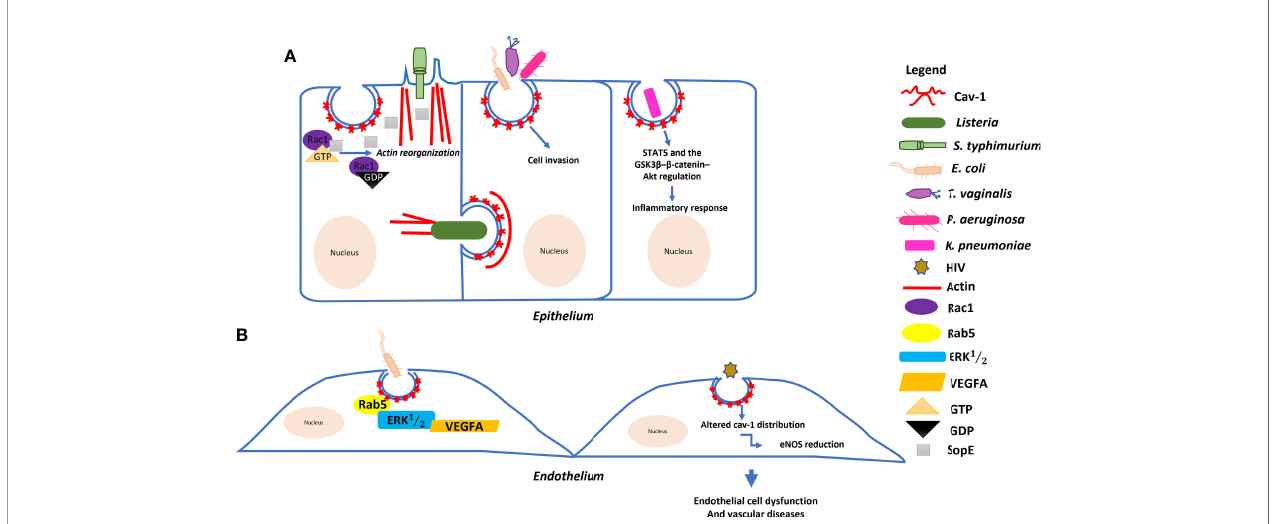
FIGURE 2 | Model of the molecular mechanism underlying the role of Cav – 1 in bacterial and HIV invasion: (A) Salmonella typhimurium delivers SopE effector proteins into the host cell through a type III secretion system. SopE activates Rac1 leading to the activation of actin reorganization. Cav – 1 interacts directly with these proteins to form a complex, enhancing Salmonella invasion into host cells. Listeria monocytogenes can trigger Cav – 1 endocytosis for cell – to – cell transfer involving actin fi laments. Pseudomonas aeruginosa , Escherichia coli and Trichomonas vaginalis empregues Cav – 1 – mediated endocytosis to invade host cells. Klebsiella pneumoniae affects both systemic and local production of proin fl ammatory cytokines via the actions of STAT5 and the GSK3 b – b – catenin – Akt pathway. (B) Endocytosis of E. coli is regulated by the small GTPase Rab5 through interaction with Cav – 1 and plays multiple roles in the VEGFA – induced signaling cascade to enhance permeability in human endothelial cells. HIV also induces endothelial cell dysfunctions through Cav –